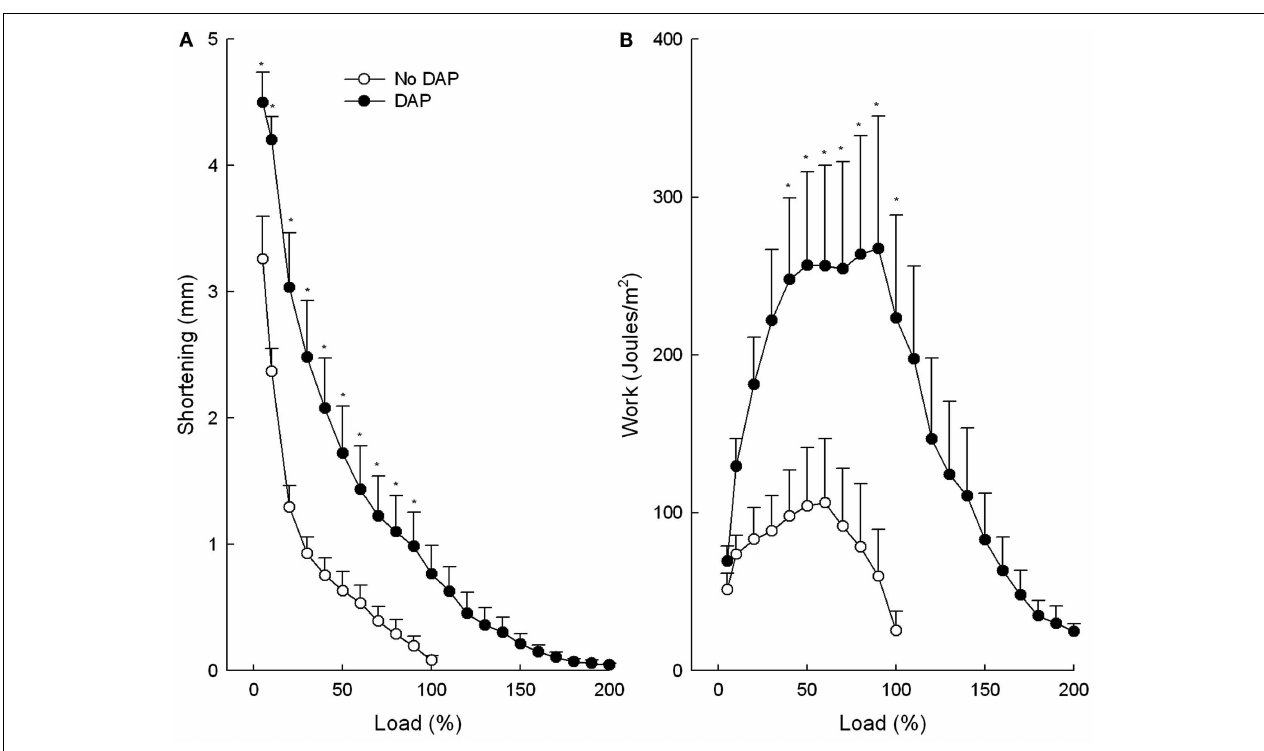
FIGURE 1 | Effects of DAP on muscle shortening (A) and work (B) during 20Hz isotonic stimulation at different loads. Load values were calculated as a function of the maximum load before the addition of DAP (or no drug).Values are means ± SE.